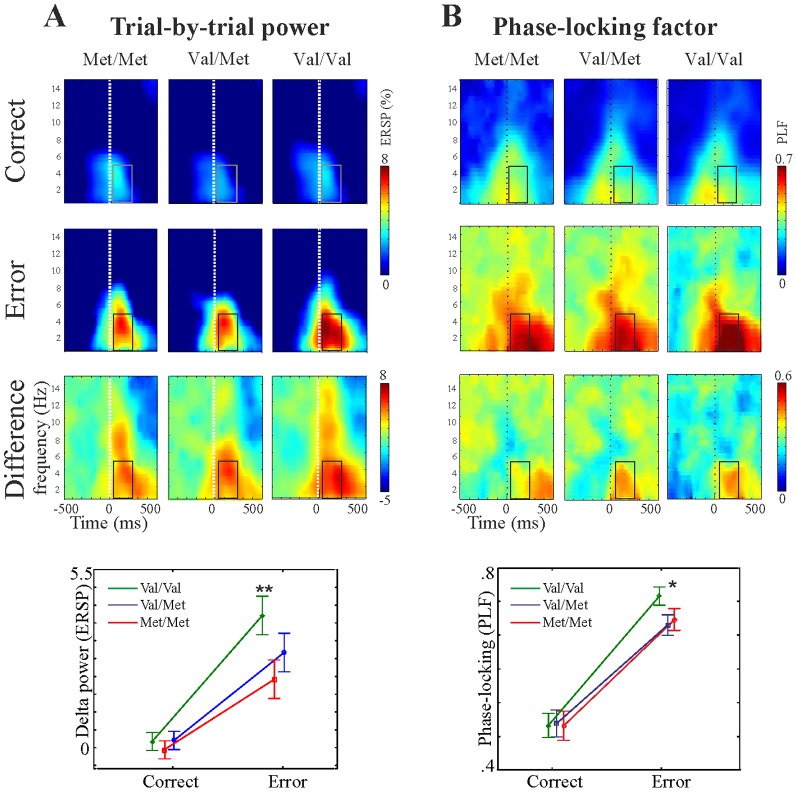
Behavioural results of the flanker task.Panel A: Event-related spectral perturbation (ERSP) during correct and error responses, and their difference (error-correct) for the three genetic groups. Boxes in the time-frequency plots indicate the time-frequency interval from which the values have been submitted to statistical analyses. Statistics are illustrated in the lower graph, bars represent standard error, **:p<0.005. Panel B: Phase-locking factor (PLF) values, as above. *:p<0.05.